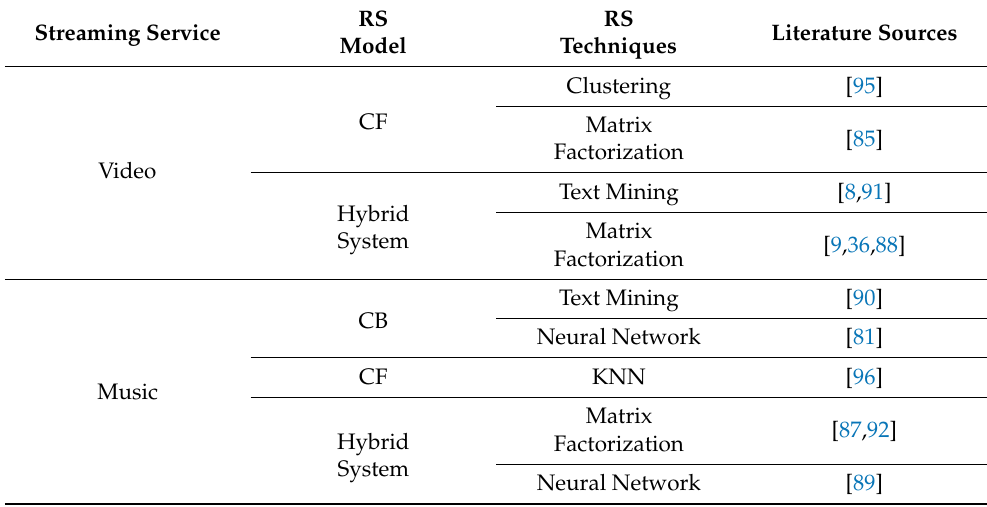
Table 5. Recommendation system study of streaming service field. Streaming Service